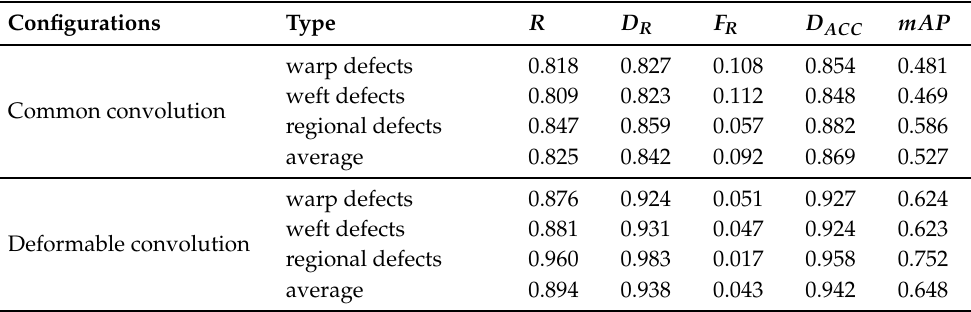
Table 2. Performance comparison of the proposed model using common convolutions and de- formable convolutions.